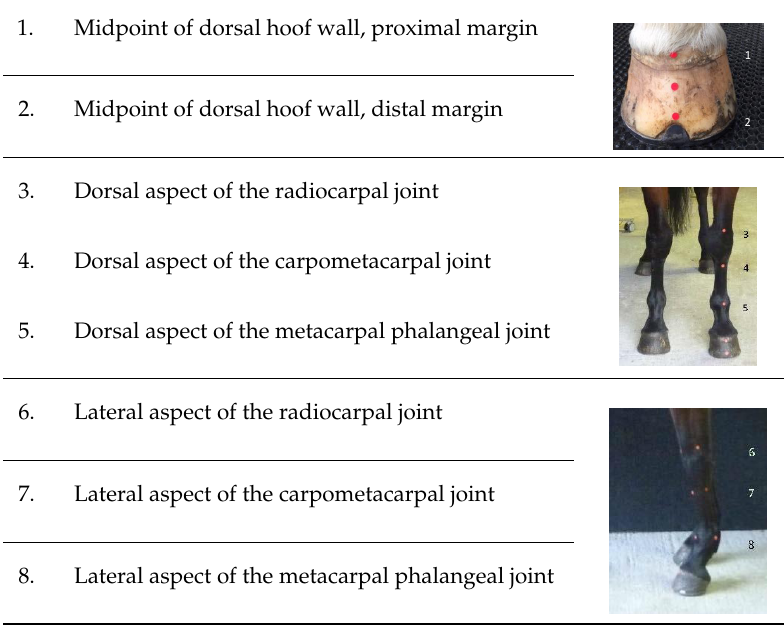
Table 1. Location of anatomical markers. 1. Midpoint of dorsal hoof wall, proximal margin